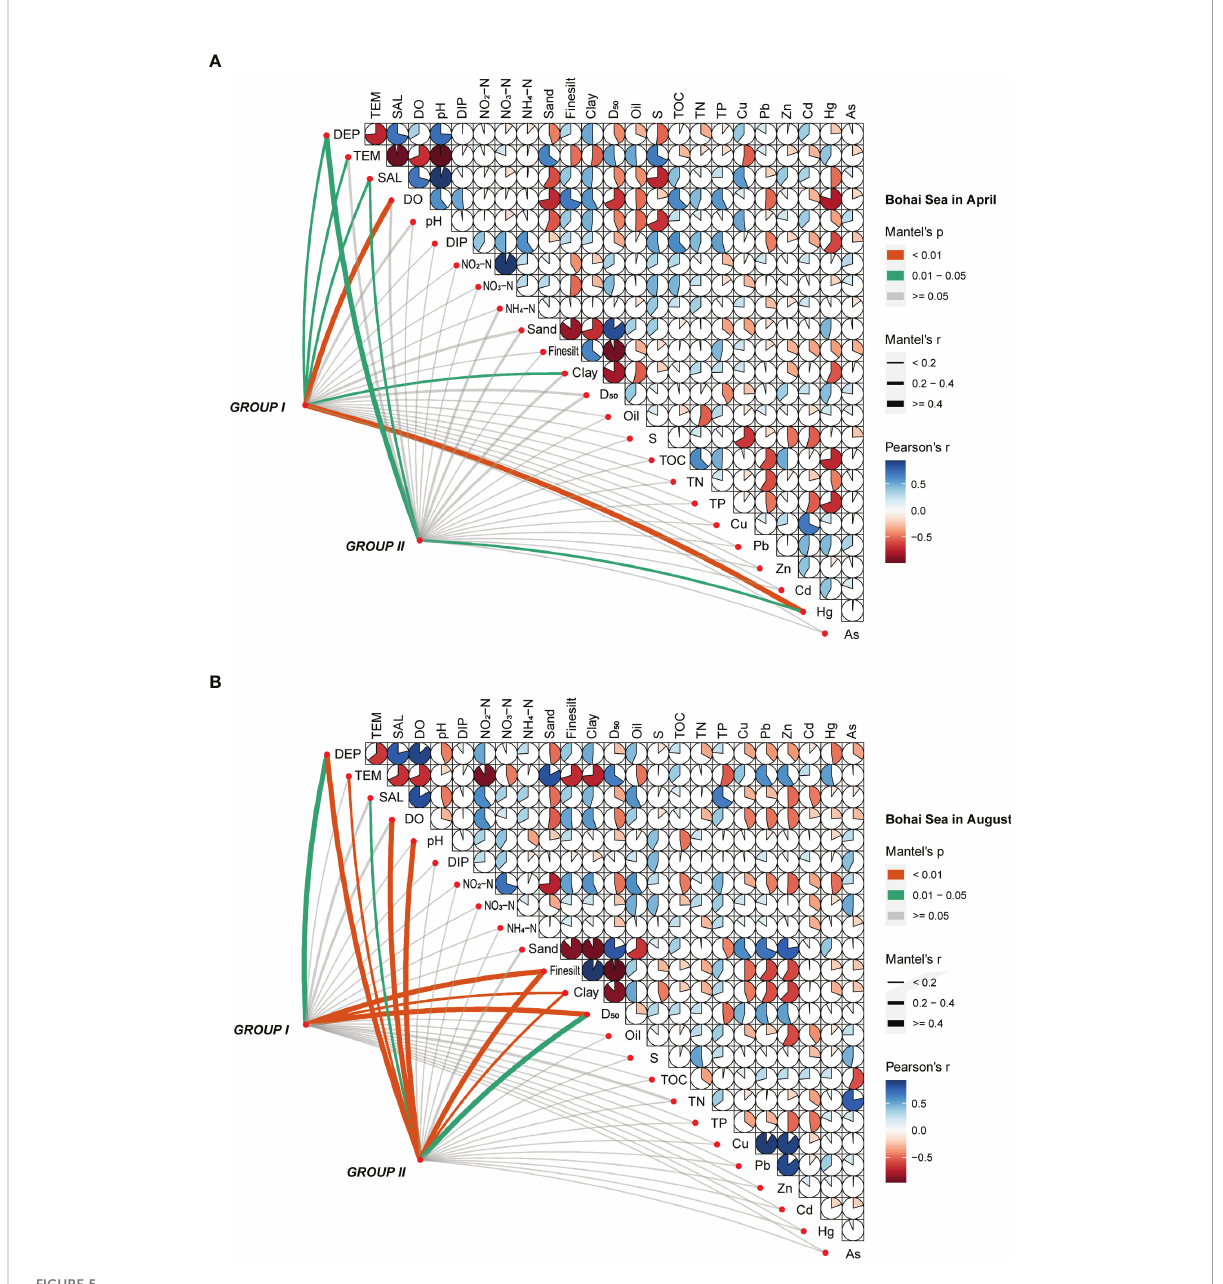
FIGURE 5 Correlations between the major macrobenthic communities and environmental factors, by month, in (A) April and (B) August of 2020, in the Bohai Sea